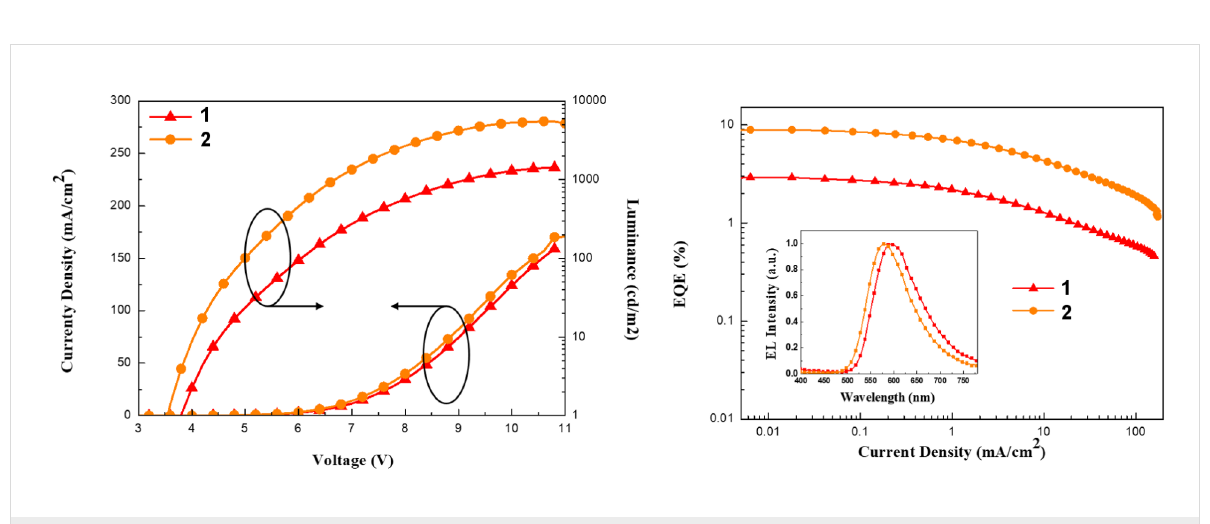
Figure 6: J – V – L (current density–voltage–luminance) (left) and EQE–current density characteristics of the devices (right). Inset: Electroluminescence spectra of the devices at a luminance of 1 cd m − 2